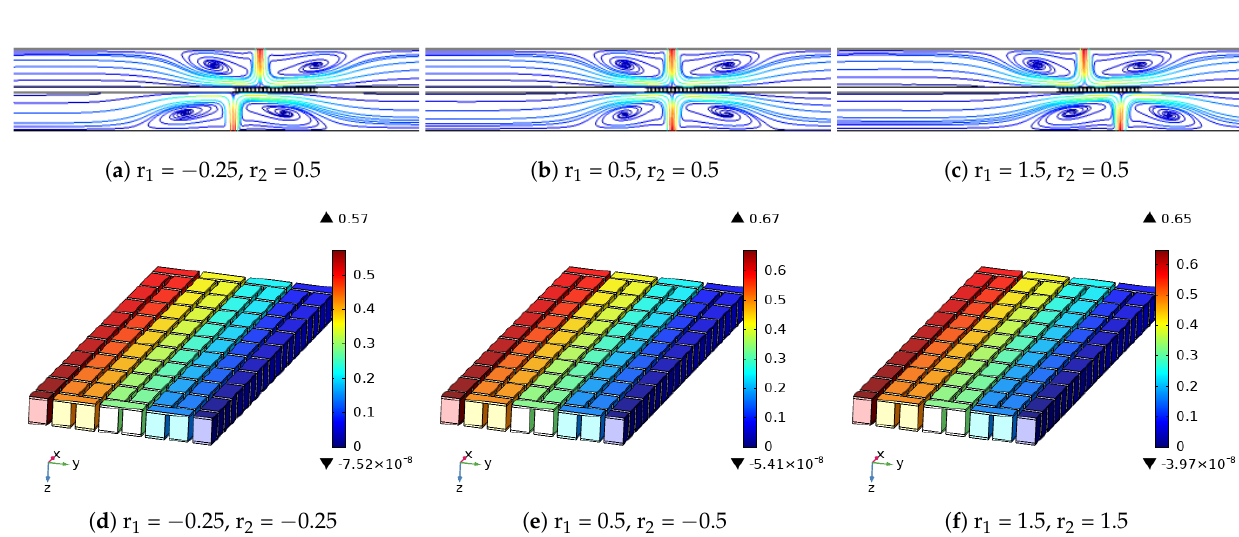
Figure 9. Effects of varying jet-stream inlet horizontal location combinations on the distribution of streamlines in the mid-plane channels ( a – c ) and electric potential variations in the TEG device ( d – f ) ((Re 1 , Re 2 ) = (500, 500), z h = 3w s , φ = 0.02).